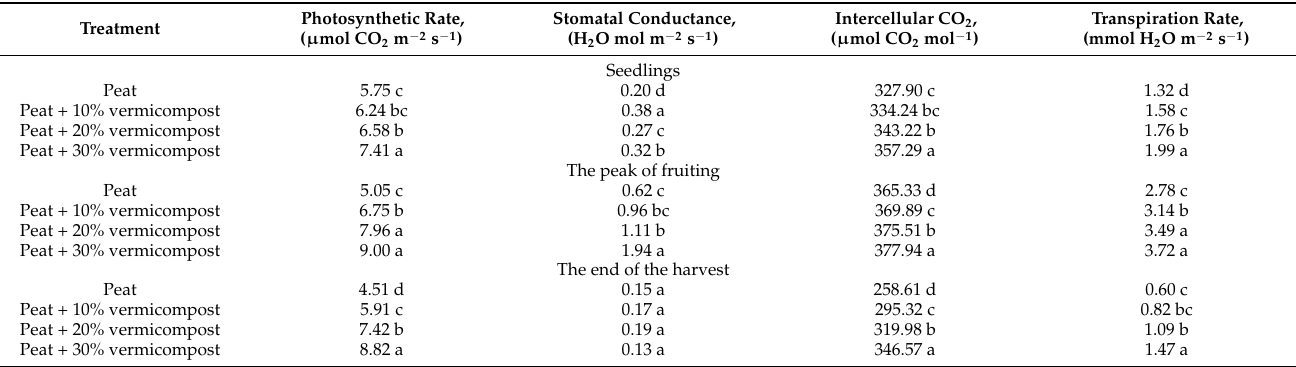
Figure 3. The effect of peat–vermicompost substrates on chlorophyll ( A ) and NBI ( B ) indices in the leaves of cucumbers seedlings: 1—peat; 2—peat+10% vermicompost; 3—peat+20% vermicompost; 4—peat+30% vermicompost. Different letters above the columns are significantly different at the p < 0.05 level according to Tukey’s significant difference test. Error bars show standard deviation. Table 5. The effect of peat–vermicompost substrates on photosynthetic parameters in the leaves of cucumber